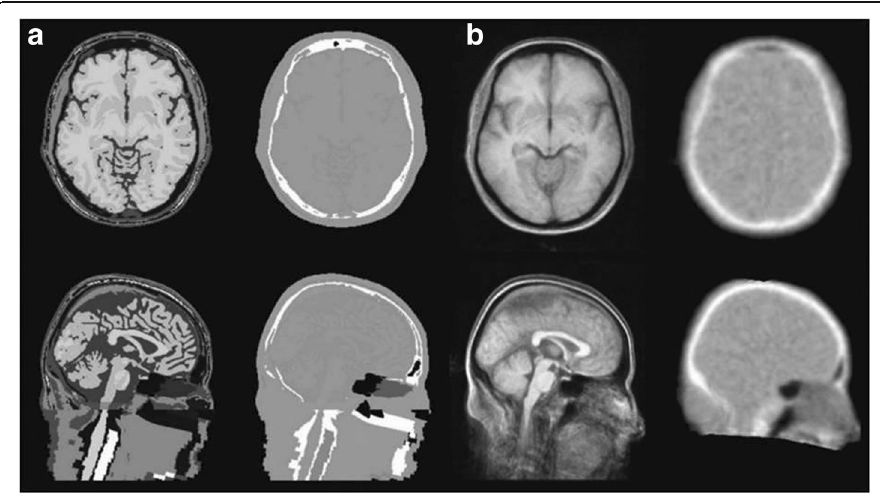
Williams, P. J. Nestor, T. A. Carpenter, and T. D. Fryer , “ Attenuation correction methods suitable for brain imaging with a PET/MRI scanner: a comparison of tissue atlas and template attenuation map approaches., (Malone et al. 2011) ” J. Nucl. Med., vol. 52, no. 7, pp. 1142 – 9, 2011. © by the Society of Nuclear Medicine and Molecular Imaging,